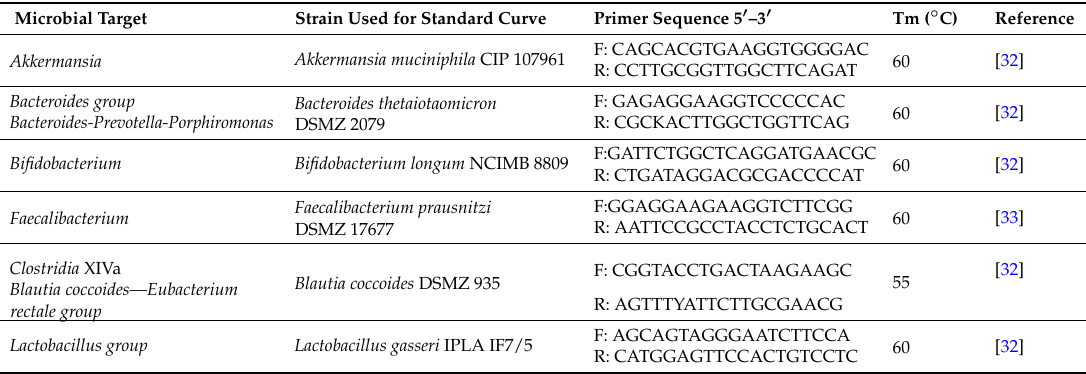
Table 1. Bacterial groups, standard cultures, primers, and annealing temperatures (Tm) used for qPCR in this study. Microbial Target Strain Used for Standard